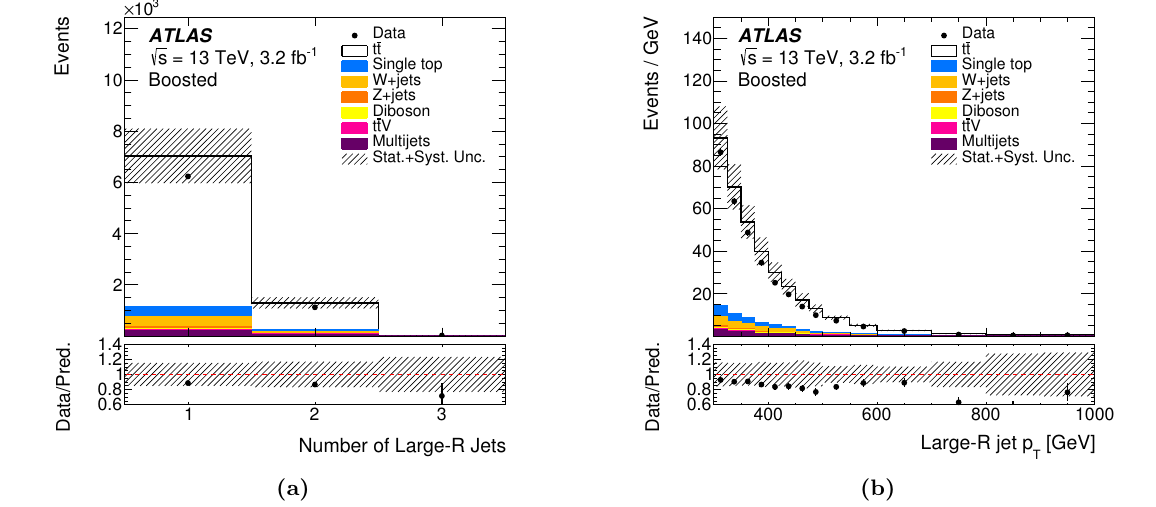
Figure 3. Kinematic distributions in the combined ‘ +jets channel in the boosted topology at detector level: (a) number of large- R jets and (b) large- R jet p T . Data distributions are compared to predictions using Powheg + Pythia6 as the t (cid:22) t signal model. The hatched area indicates the combined statistical and systematic uncertainties in the total prediction, excluding systematic un- certainties related to the modelling of the t (cid:22) t system. Events beyond the range of the horizontal axis are included in the last